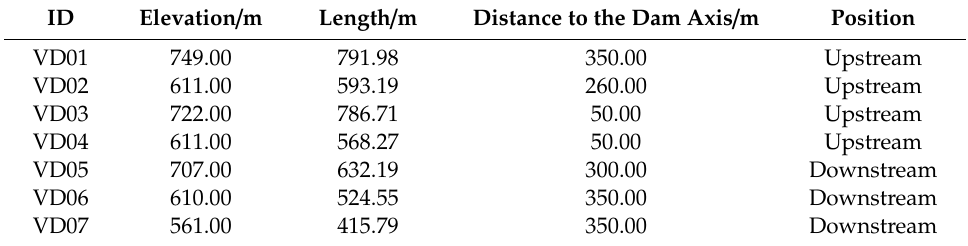
Table 1. Information on the survey line to monitor valley deformation.